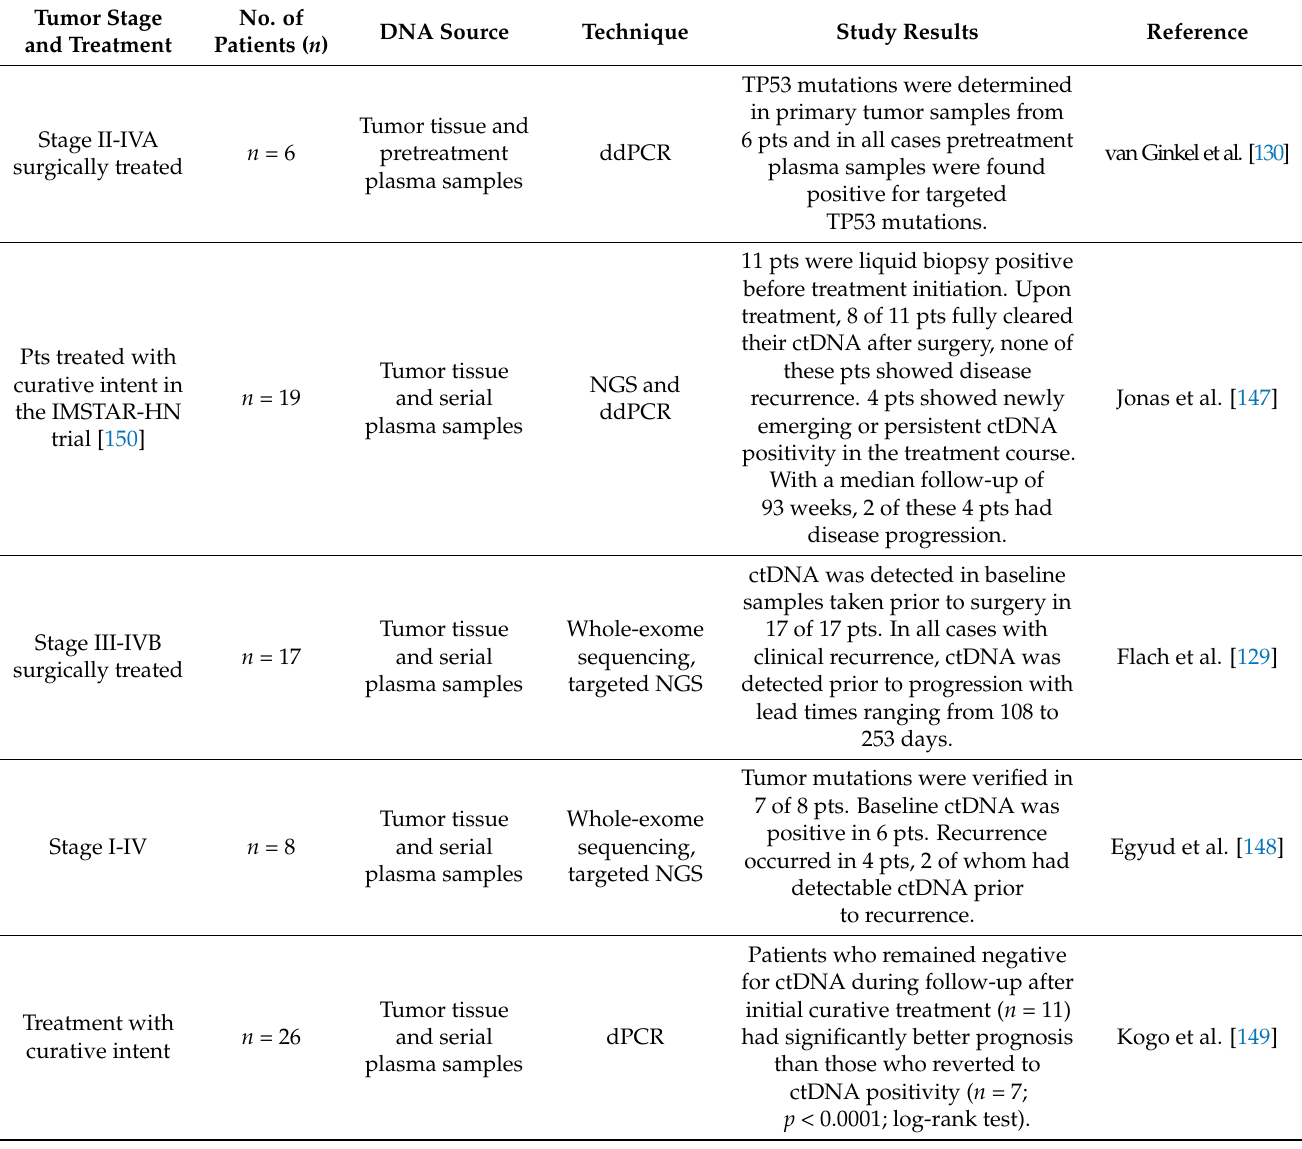
Table 1. Key studies on liquid biopsy applications in